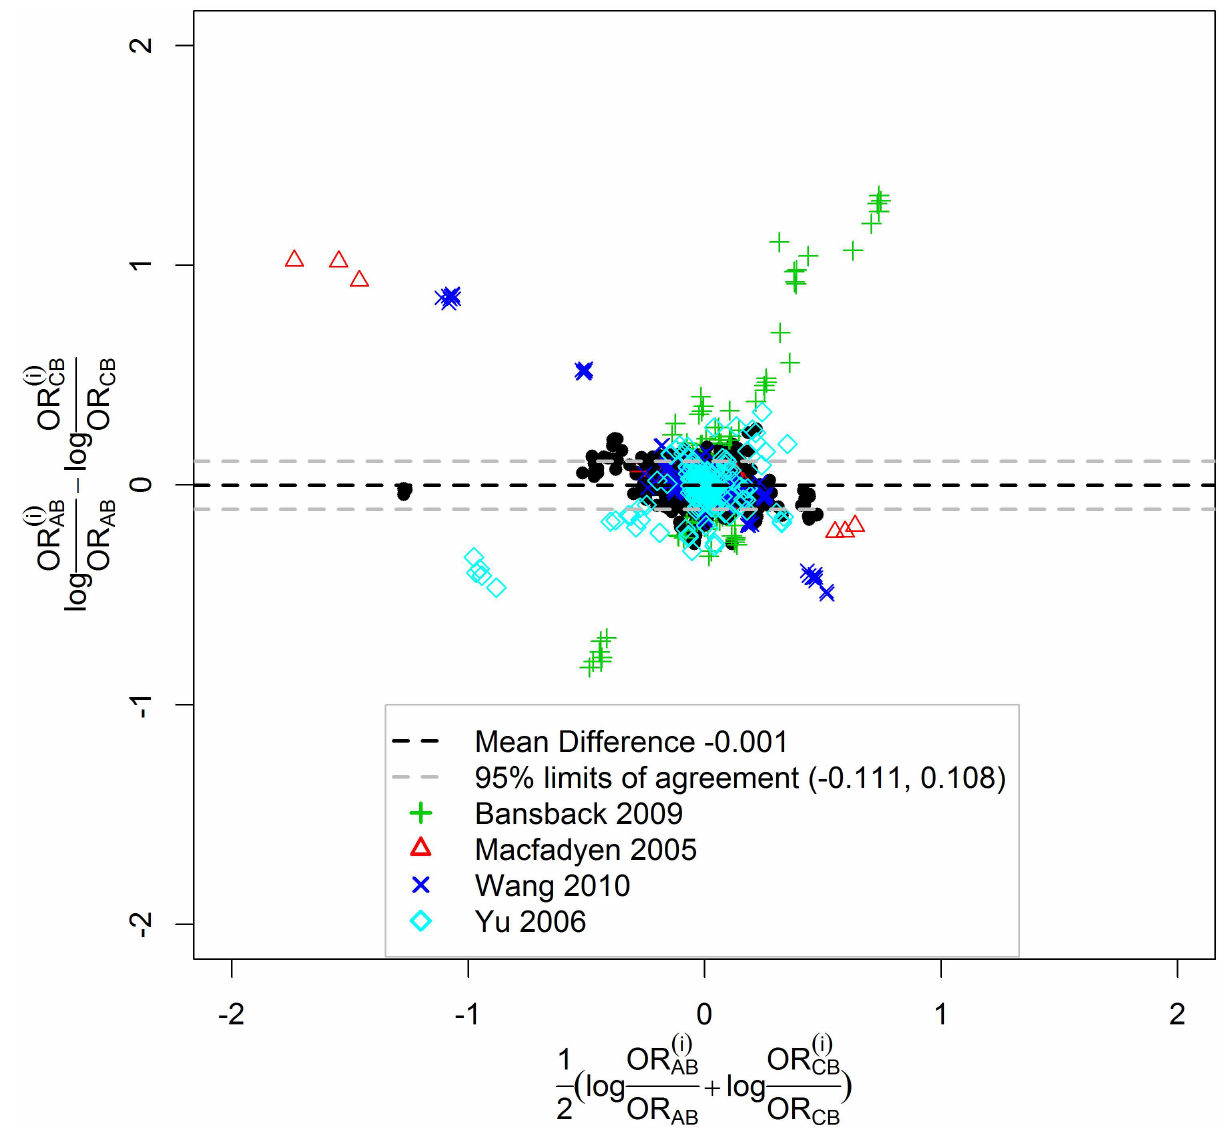
Fig 3. Bland-Altman plot. The differences betweenthe AB and CB approaches in terms of log OR changesafter omissionof trials, i.e., ð i Þ ð i Þ (cid:0) log OR log OR , is drawn agaist the mean, i.e., 1 CB AB OR AB OR CB dashedlines. Four networksare highlighted in